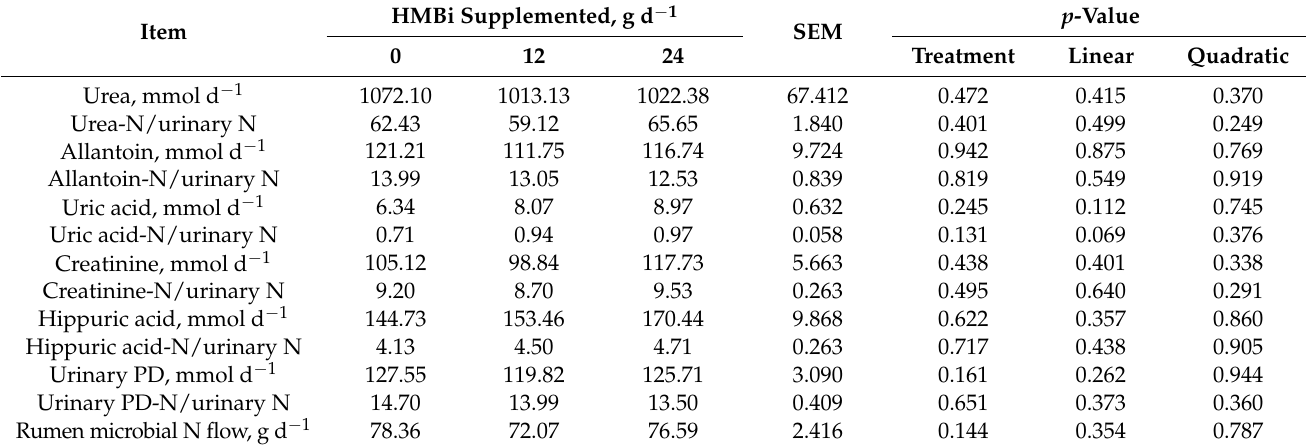
Table 4. Effects of supplementing HMBi on urinary N compounds in